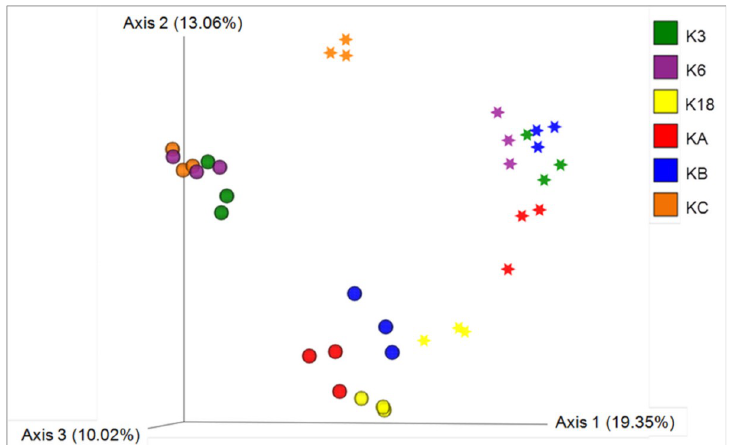
Fig 2. Principal component analysis of samples based on unweighted UniFrac distance matrix. Different colors indicate samples from different stations. Sphere : Samples collected during the summer season; Star : Samples collected during the winter season.